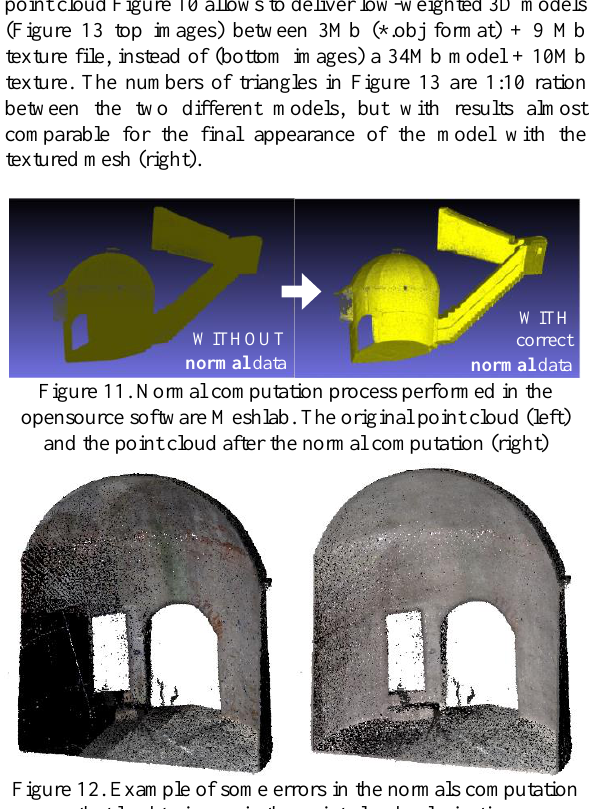
Figure 12. Example of some errors in the normals computation that lead to issues in the point cloud colorization